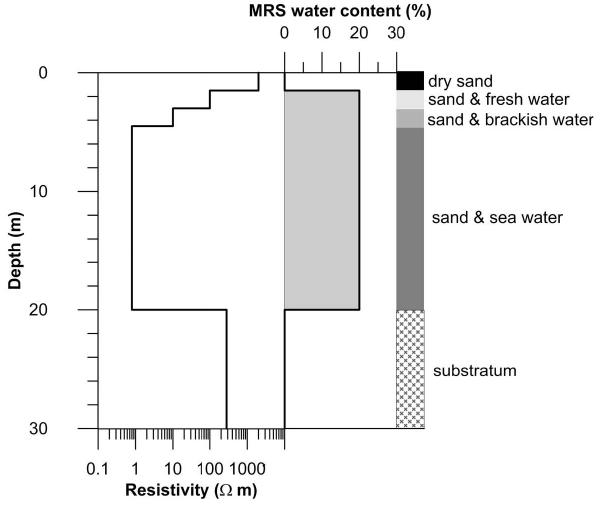
Fig. 1. Geoelectrical and water content models with a thickness of 1.5m for the first 3 layers. Numerical modelling is conducted with a thickness of the first 3 layers ranging from 1.5 to 10m and con- sidering a water content of 20% in medium- to coarse-grained sand ( T ∗ 2